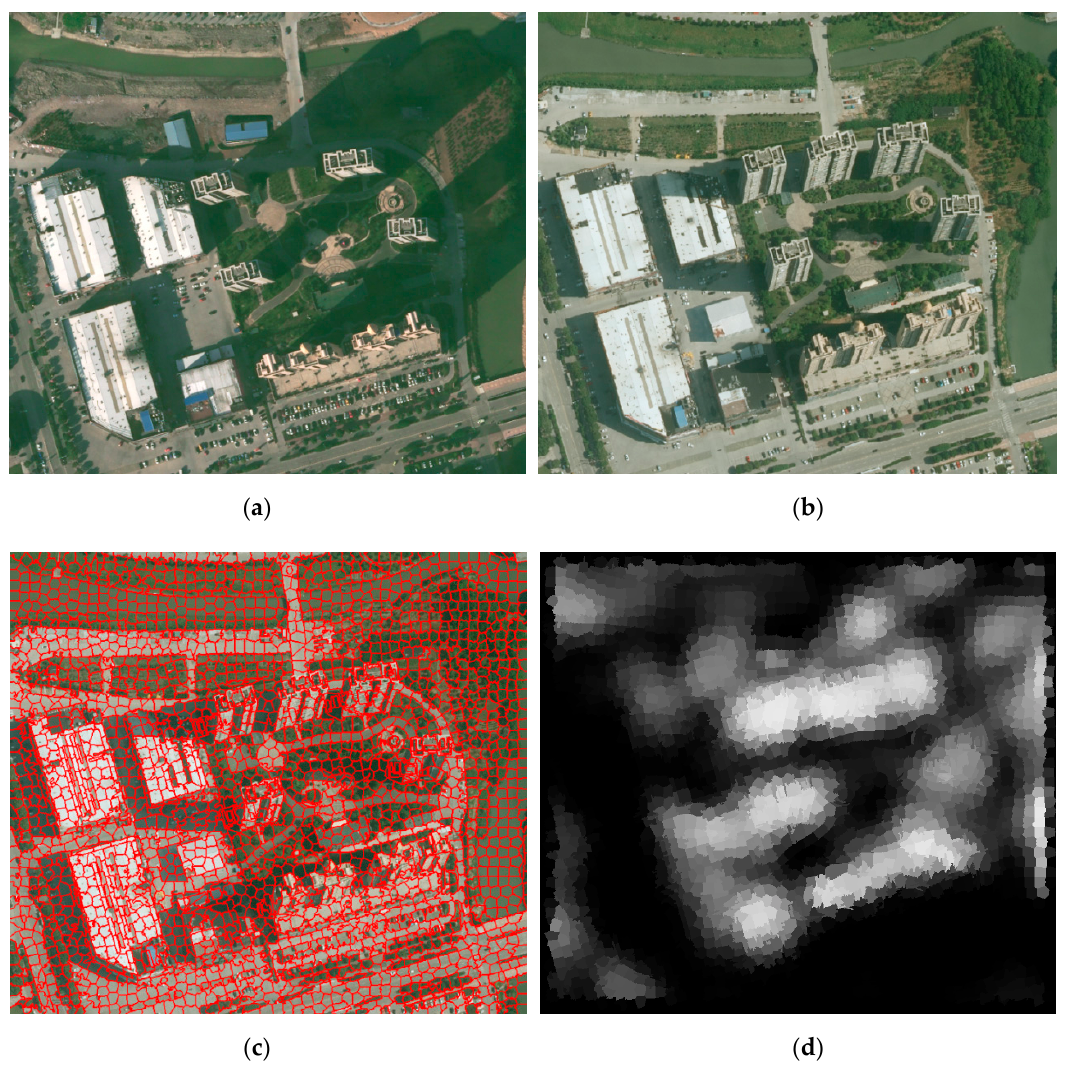
Figure 3. Bi-temporal images, the corresponding image-object, and change confidence map. ( a ) The RGB aerial image at time t 1 , ( b ) the RGB aerial image at time t 2 , ( c ) superposition of the bi-temporal image-object and the RGB aerial image at time t 2 , and ( d ) the change confidence map.